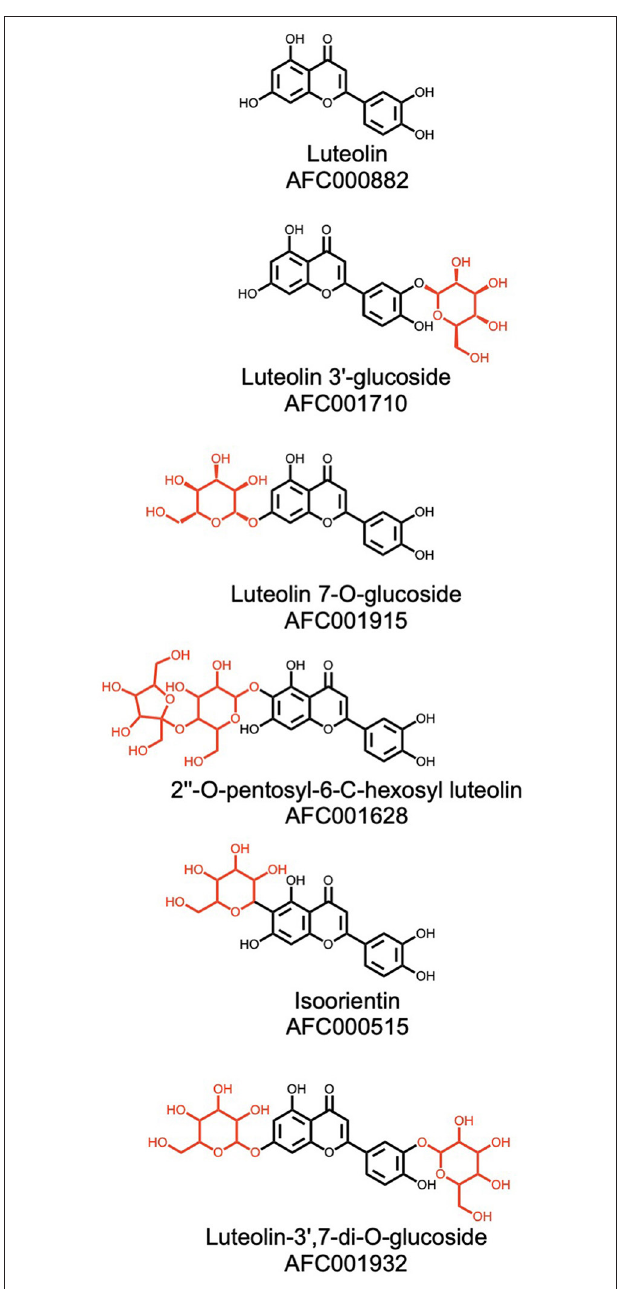
FIGURE 10 | Luteolin and its glycosylated derivatives that are present in watermelon. The structure of the luteolin aglycon is depicted in black and the sugar moieties are in red. Please refer to Materials and Methods (section AFC Identifiers) for the definition of the AFC